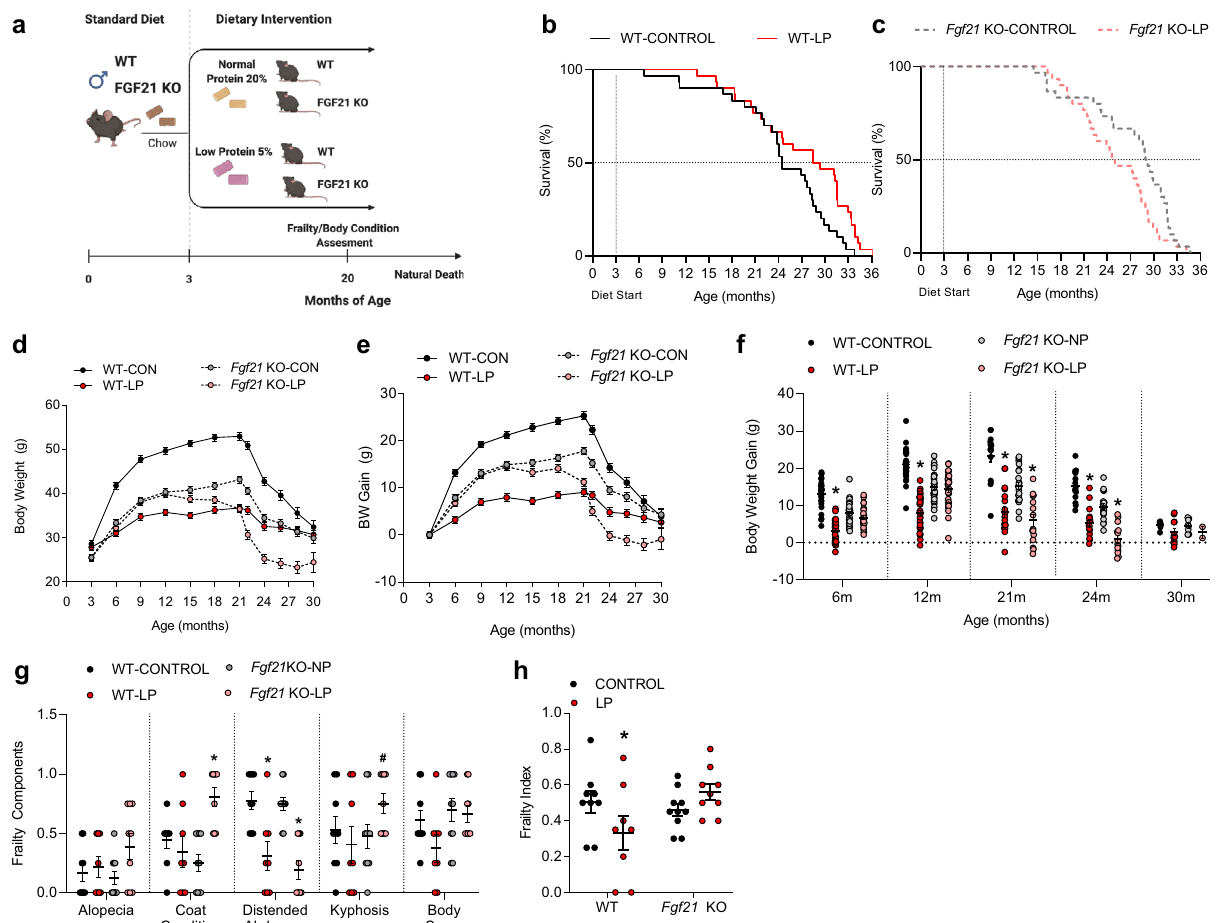
Fig. 1 Deletion of FGF21 reverses the bene fi cial effects of dietary protein restriction on lifespan. a Schematic representation of the longevity study. Wildtype and Fgf21 -KO mice were placed on control or LP diet at 3 months of age and monitored until natural death. b Kaplan – Meier survival curve for wildtype mice on LP diet, indicating an extension of lifespan in WT mice on LP. n = 30 per group. c Kaplan – Meier survival curve for Fgf21 -KO mice on LP, indicating a reduction in lifespan in Fgf21 KO mice on LP. n = 30 mice per group. d , e Bodyweight and bodyweight gain curves based on the initiation of diets, group*time p = 0.001. f Comparison of body weight change at speci fi c time points, group*time p = 0.001. g Speci fi c components were used from the Howlett Frailty Index assessed at 20 months of age, n = 9 – 10 mice per group; alopecia geno*diet p = 0.2115, coat condition geno*diet p = 0.0009, distended abdomen diet p = 0.0001, kyphosis geno*diet p = 0.09, body score geno*diet p = 0.2854. h , Frailty Index as an average from individual components in g, geno*diet p = 0.02. Statistical analyses were conducted using survival analysis for lifespan and one-way or two-way ANOVA for BW change and Frailty. Values are mean ± SEM, with signi fi cant posthoc comparison within the diet*genotype interaction noted as * p < 0.05 and # p < 0.10 compared with respective control. Source data are provided as a Source Data